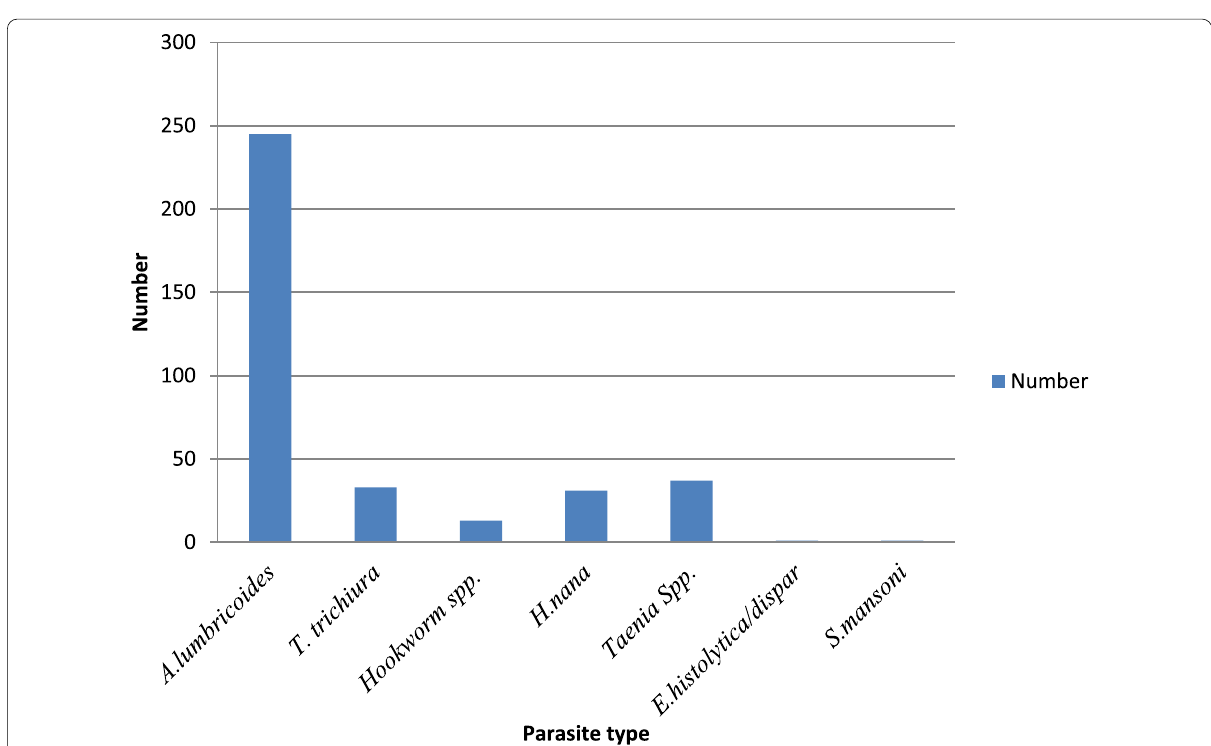
Fig. 2 Identified parasitic species among study participants, Gedeb District, Gedeo Zone, southern Ethiopia, 2021